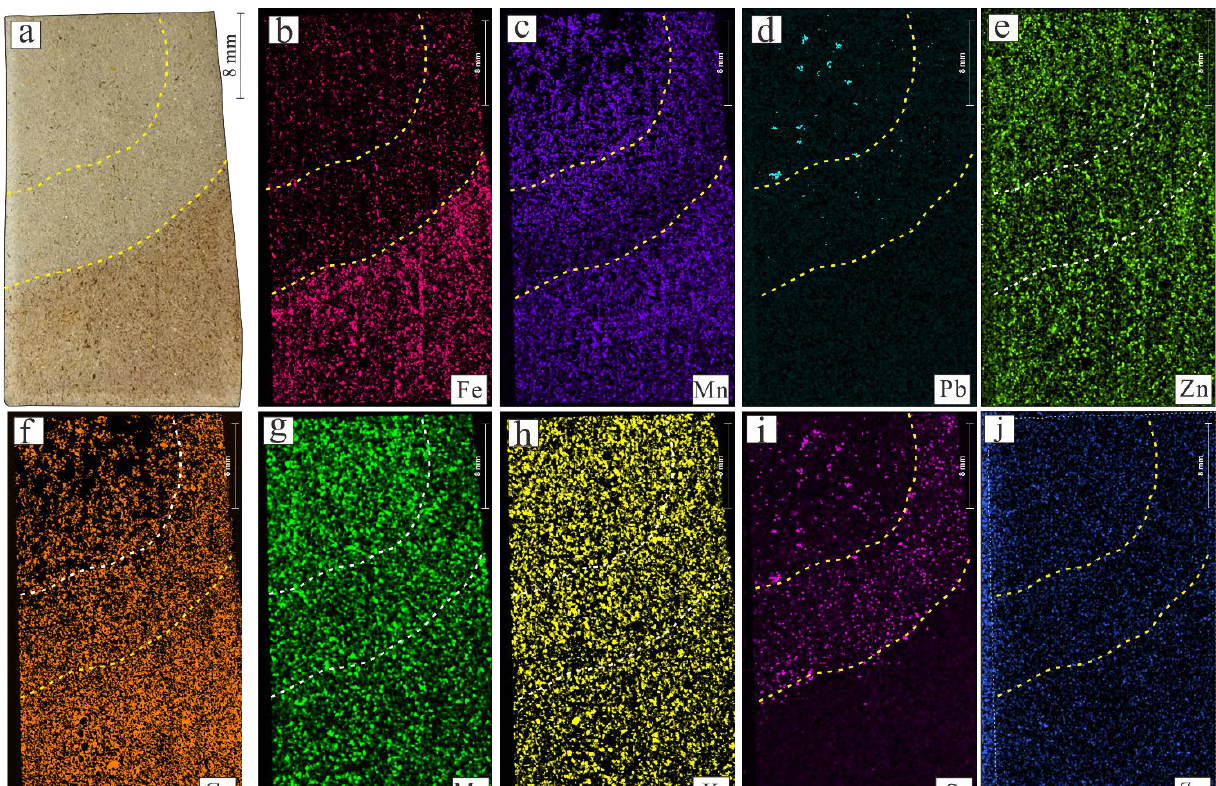
Figure 8. The changes in mineral percentage of red and bleached sandstone in the different zones by TIMA.